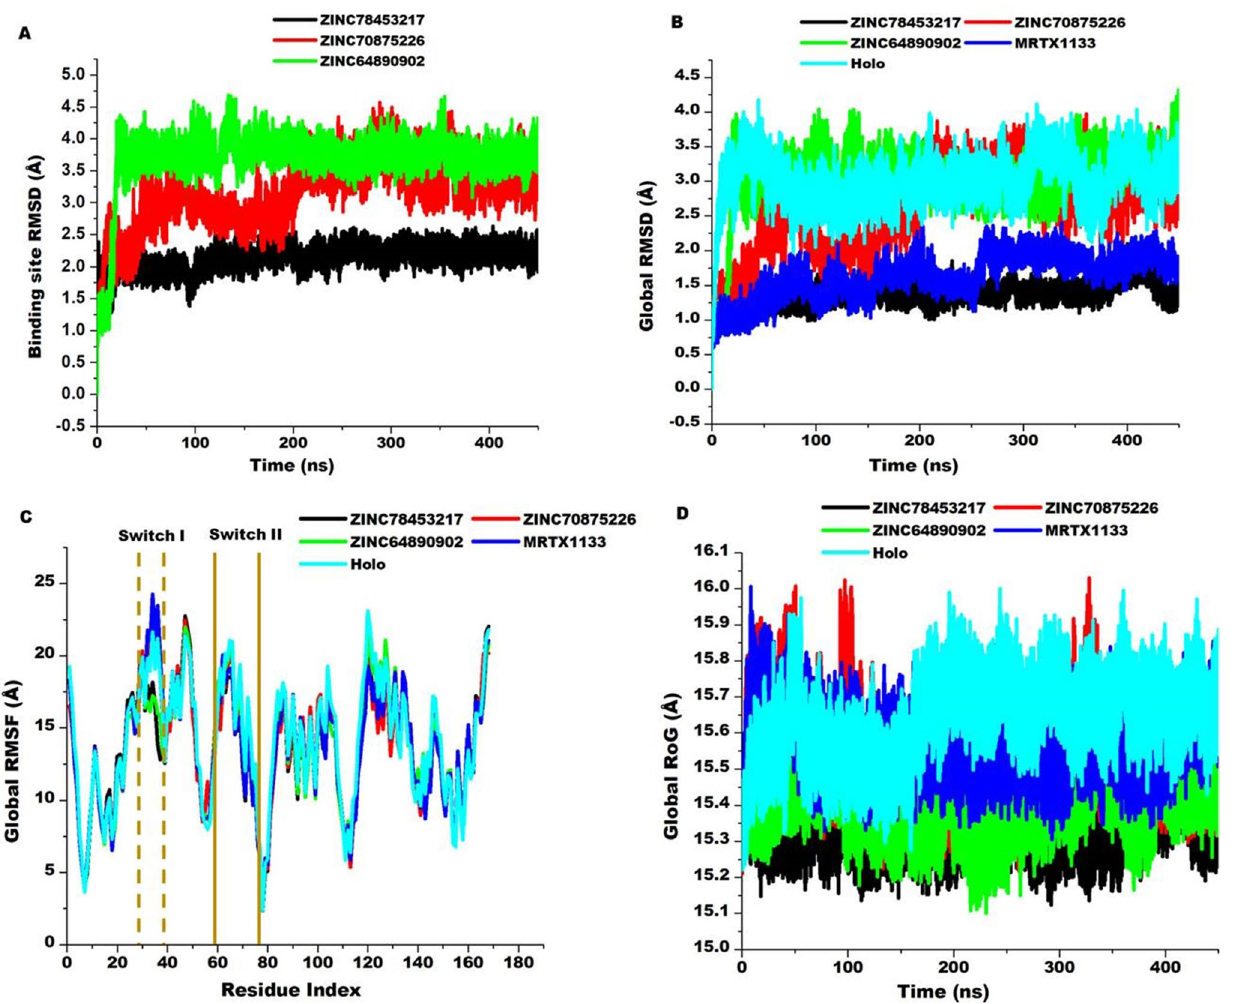
Figure 11. Comparative RMSD, RMSF and RoG plots of the hit compounds, MRTX1133 and unbound (holo) KRAS G12D protein. ( A ) Shows the binding site RMSD elicited by the binding of the hit compounds. ( B ) Depicts the global stability of KRAS G12D upon compounds binding. ( C ) Shows the residual fluctuations exhibited by the global protein residues during the simulation period. Highlights (deep yellow) show the switches regions. ( D ) Shows the RoG exhibited by the global protein. The bound conformations are contrasted to the unbound (Holo).